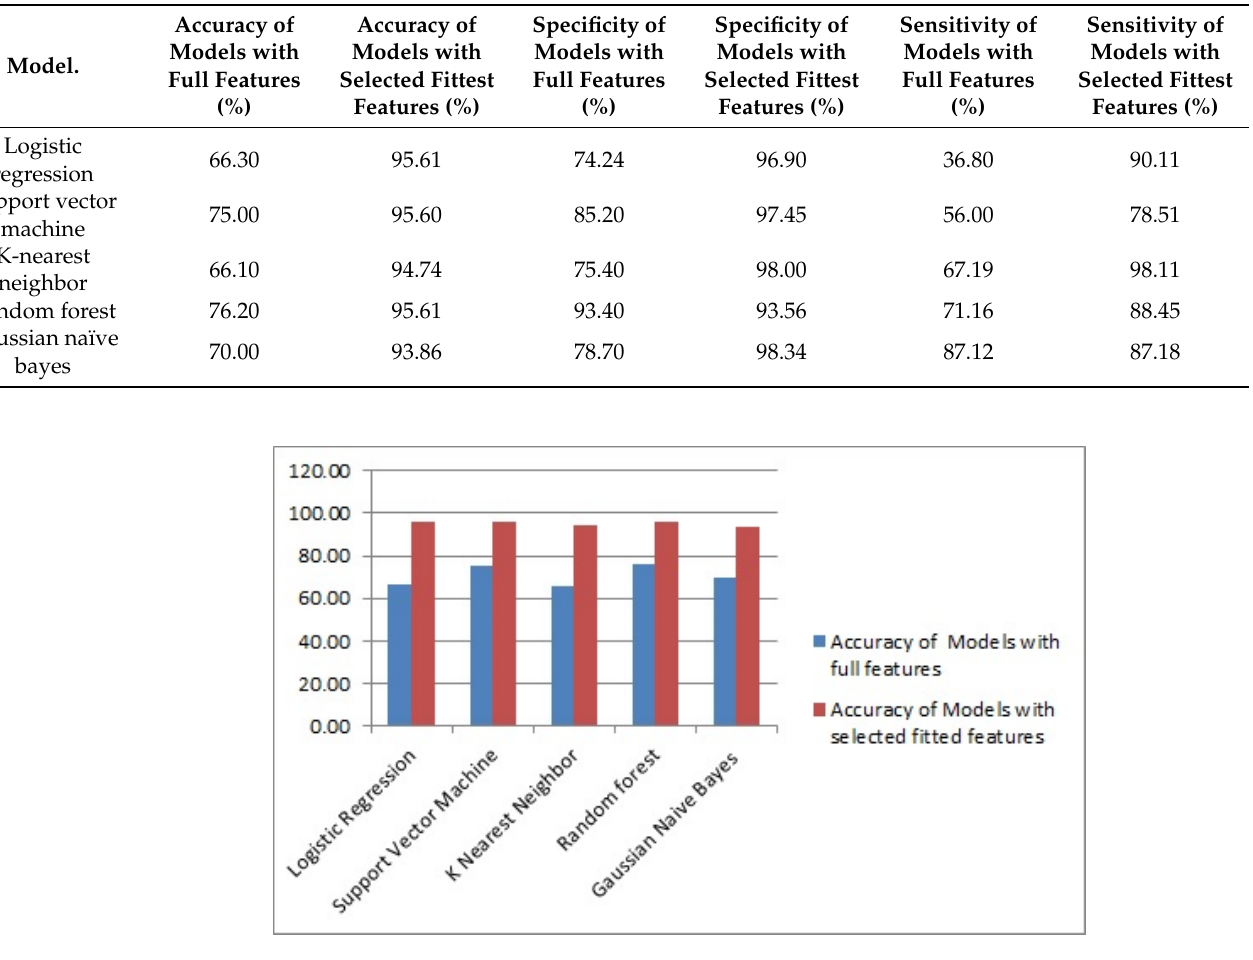
Figure 9. Chart presentation of the accuracy of the classification models with full features against that of the models with selected fittest features.